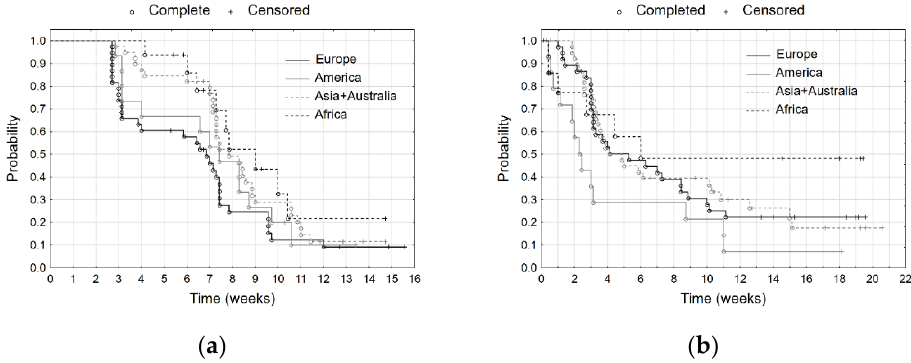
Figure 8. Kaplan–Meier estimator—probability of not reaching the 20% decline ( a ) and increase ( b ) in stock market indices by continent. Source: own elaboration, Statistica. Table 2. Results of the Peto–Peto test ( N = 108). Source: own elaboration, Statistica.